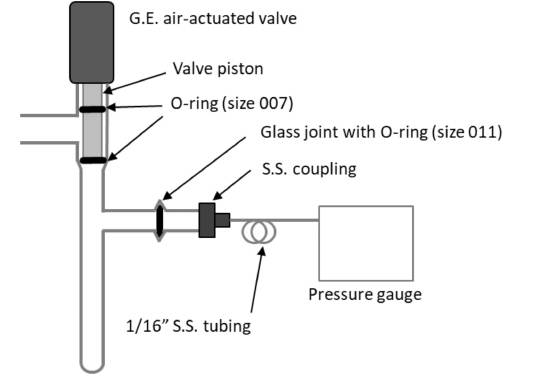
Figure 3. Diagram of the small volume showing position of Viton O-rings in the air-actuated valve (Glass Expansion, Pocasset, MA) and a glass